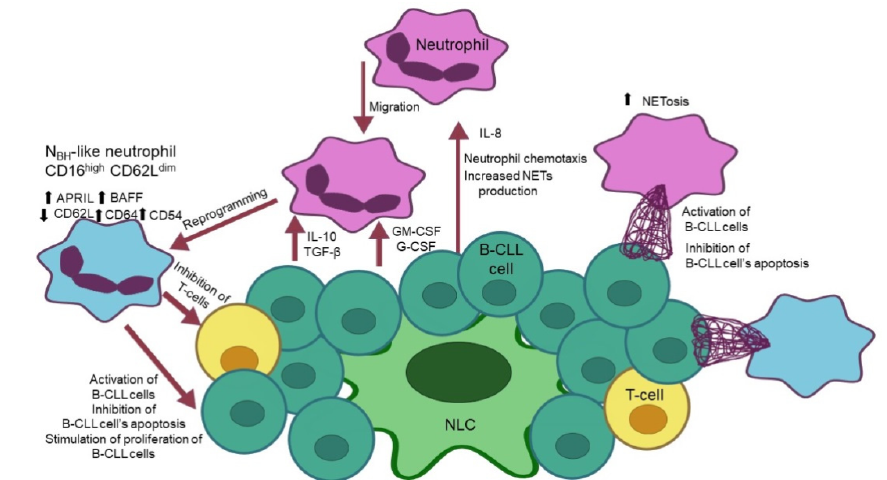
Figure 1. The summary of molecular and phenotypic changes that neutrophils undergo in prolifera- tion centers of CLL. Secretion of IL-8 in the proliferation center (PC) causes neutrophil chemotaxis, resulting in their migration to PC and increased NETs production. Malignant B lymphocytes and nurse-like cells (NLC) produce G-CSF, GM-CSF, IL-10, and TGF- β leading to reprogramming of neutrophils to B-CLL helper-like neutrophils (NBH-like). Reprogrammed neutrophils became B cell helper like neutrophils CD16 high CD62L dim. Expression of APRIL, BAFF, CD64, and CD54 is upregulated, while expression of CD62L is downregulated. Neutrophils cause the activation of B-CLL cells, inhibition of their apoptosis and stimulation of cells’ proliferation. NETs formation in CLL PC is increased, which results in activation of B-CLL cells and inhibition of their apoptosis. Funding: